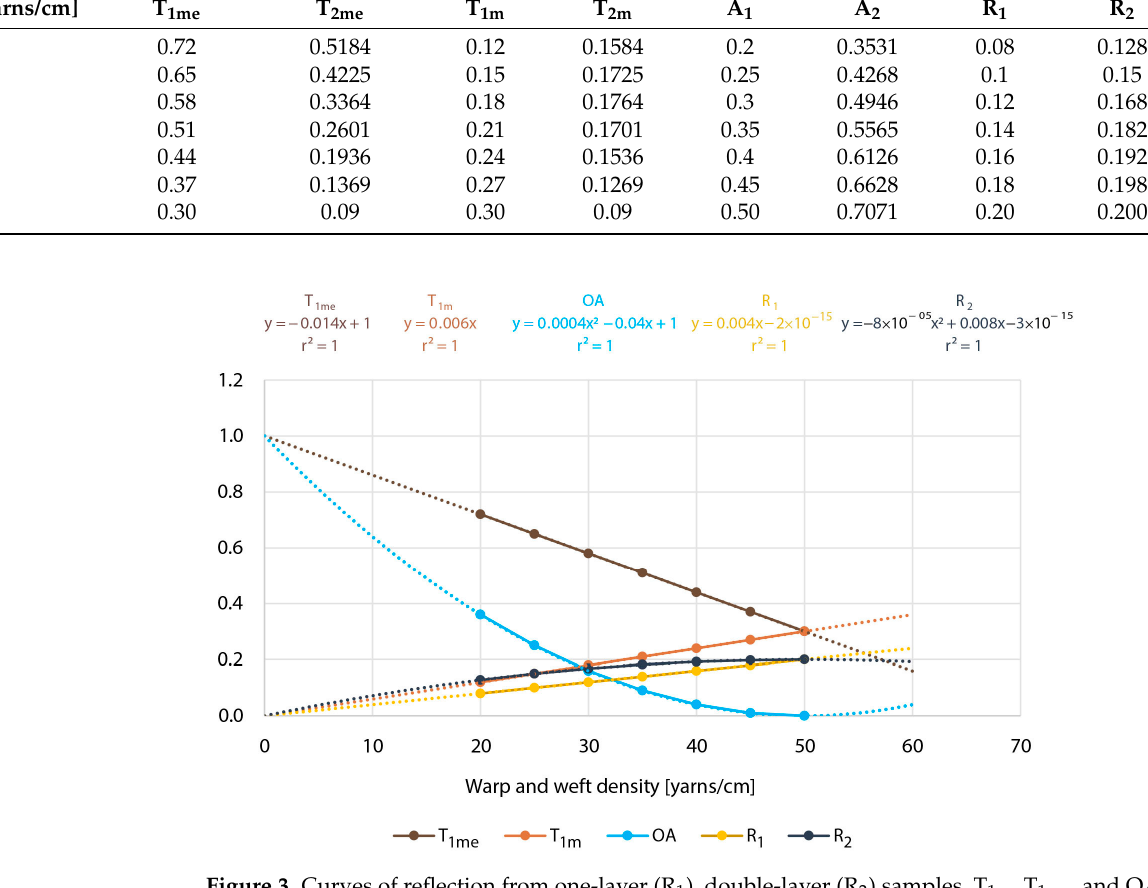
Figure 3. Curves of reflection from one-layer (R 1 ), double-layer (R 2 ) samples, T 1m , T 1me , and OA of double-layer samples.